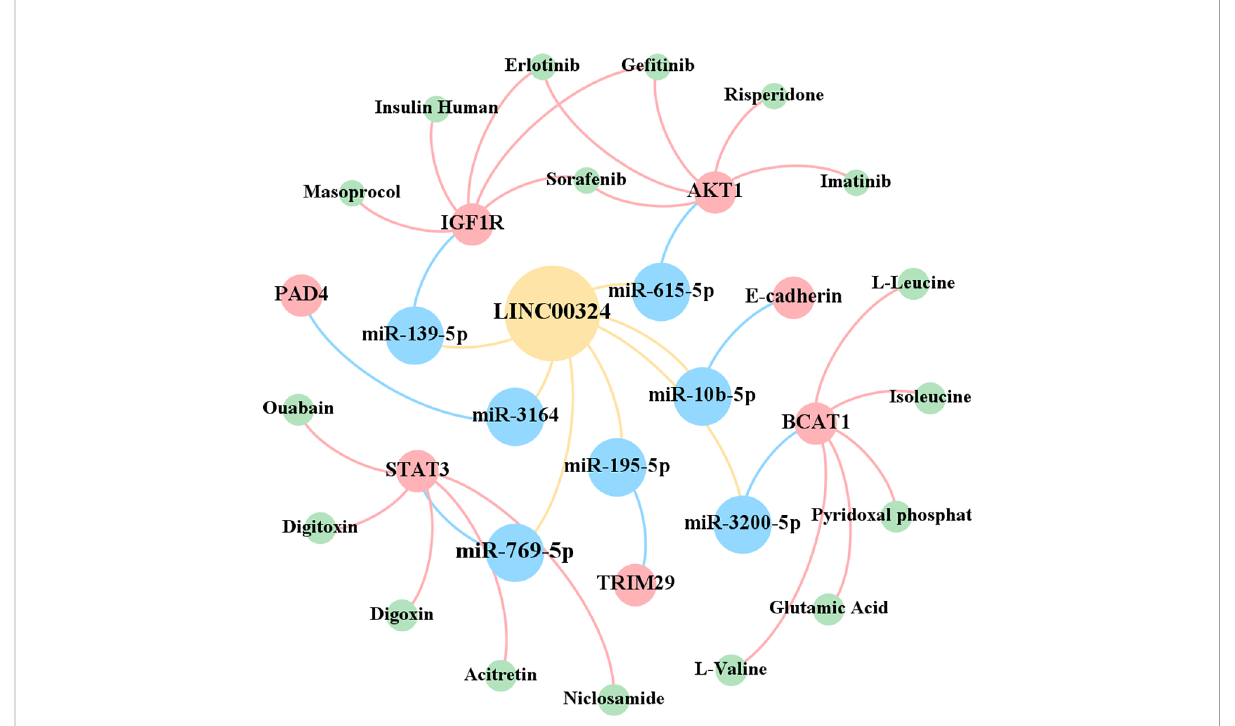
FIGURE 5 Therapeutic drugs related to target genes.